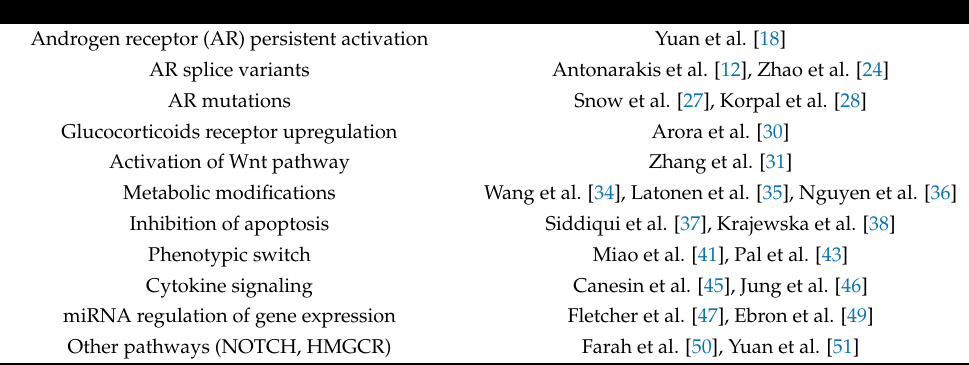
Table 2. Mechanisms of resistance to